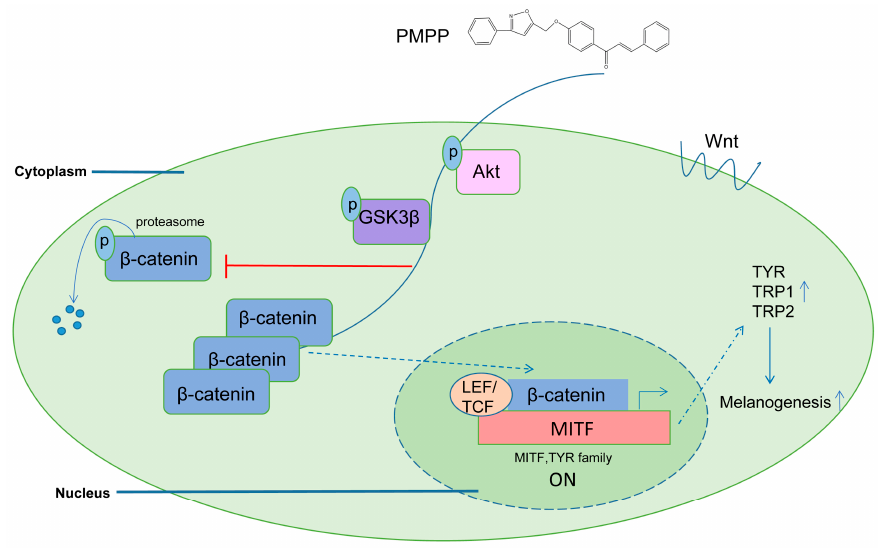
Figure 8. The possible mechanism of PMPP activating melanin content in B16 cells. PMPP increases the phosphorylation of Akt, and thus probably increases the non-activated GSK3 β , which inhibits the phosphorylation of β -catenin and ceases its degradation via proteasomes. β -catenin accumulating in cytoplasm up-regulates MITF content through promoting transcription with LEF/TCF (Lymphoidenhancer factor/T cell factor) after coming into nucleus. The augmentation of β -catenin probably leads to the increases in the transcription of MITF and the TYR family and the subsequent induction of melanin synthesis.